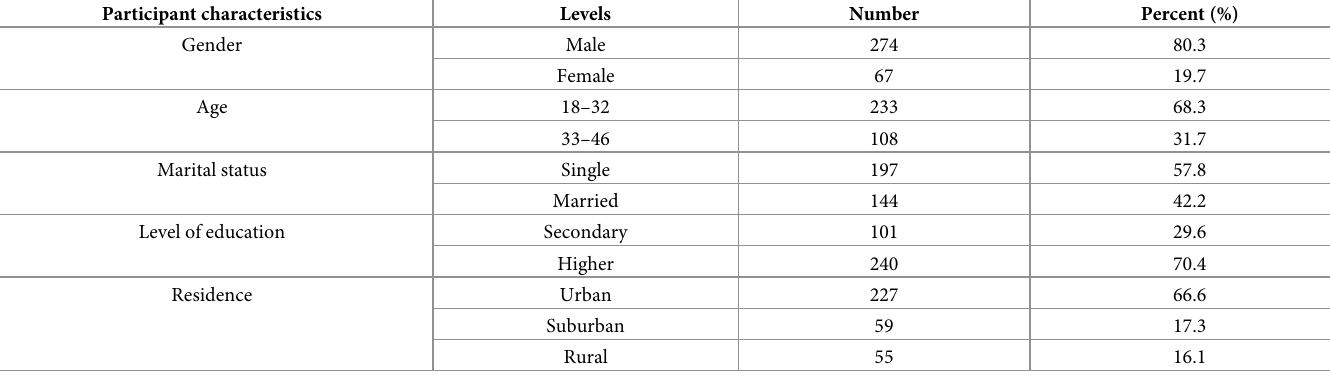
Table 1. Sociodemographic characteristics of respondents to assess prevention knowledge and practice among the community towards the COVID-19 pandemic in Ethiopia (N = 341). Participant